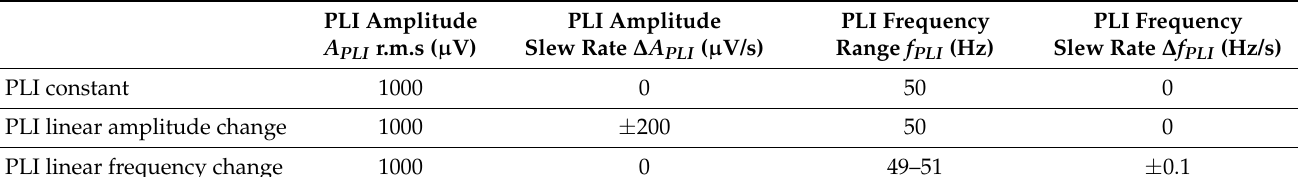
Table 1. Simulation parameters of PLI with duration of 10 s for 3 optimization scenarios with CTS-ECG calibration database.